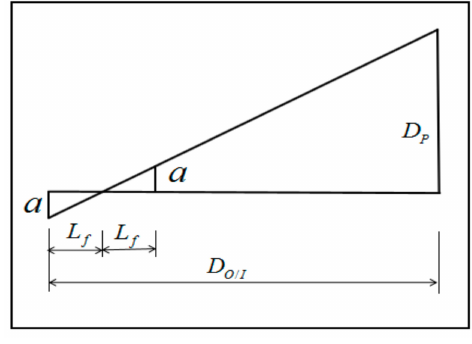
Figure 4. Calculation principle of object distance.